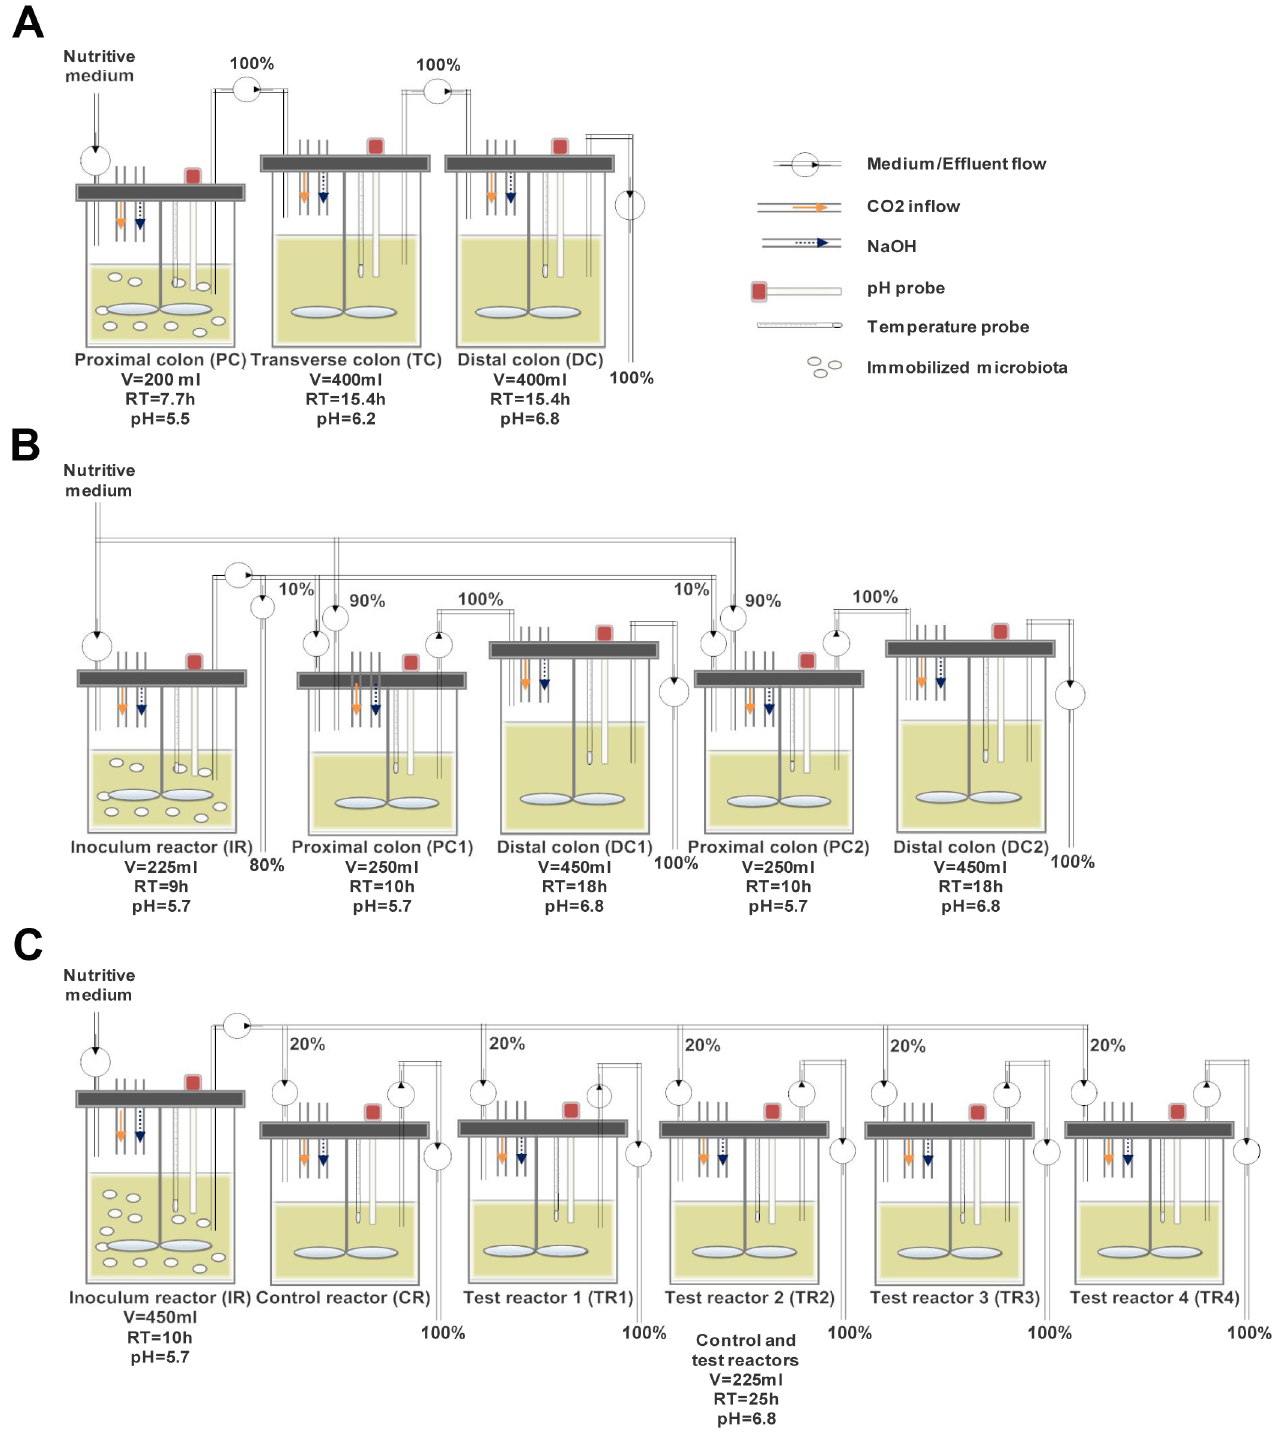
Fig 1. Set-up of the continuous fermentation models with immobilized gut microbiota. (A) Model 1. 3-stage model consisting of a proximal, transverse and distal colon reactor (B) Model 2. 2-stage model with an inoculum reactor connected to two parallel test systems consisting of a proximal and distal colon reactor (C) Model 3. 2-stage model with an inoculum reactor (proximal colon conditions) feeding 5 distal colon reactors connected in parallel; RT: Retention time, V: Volume.